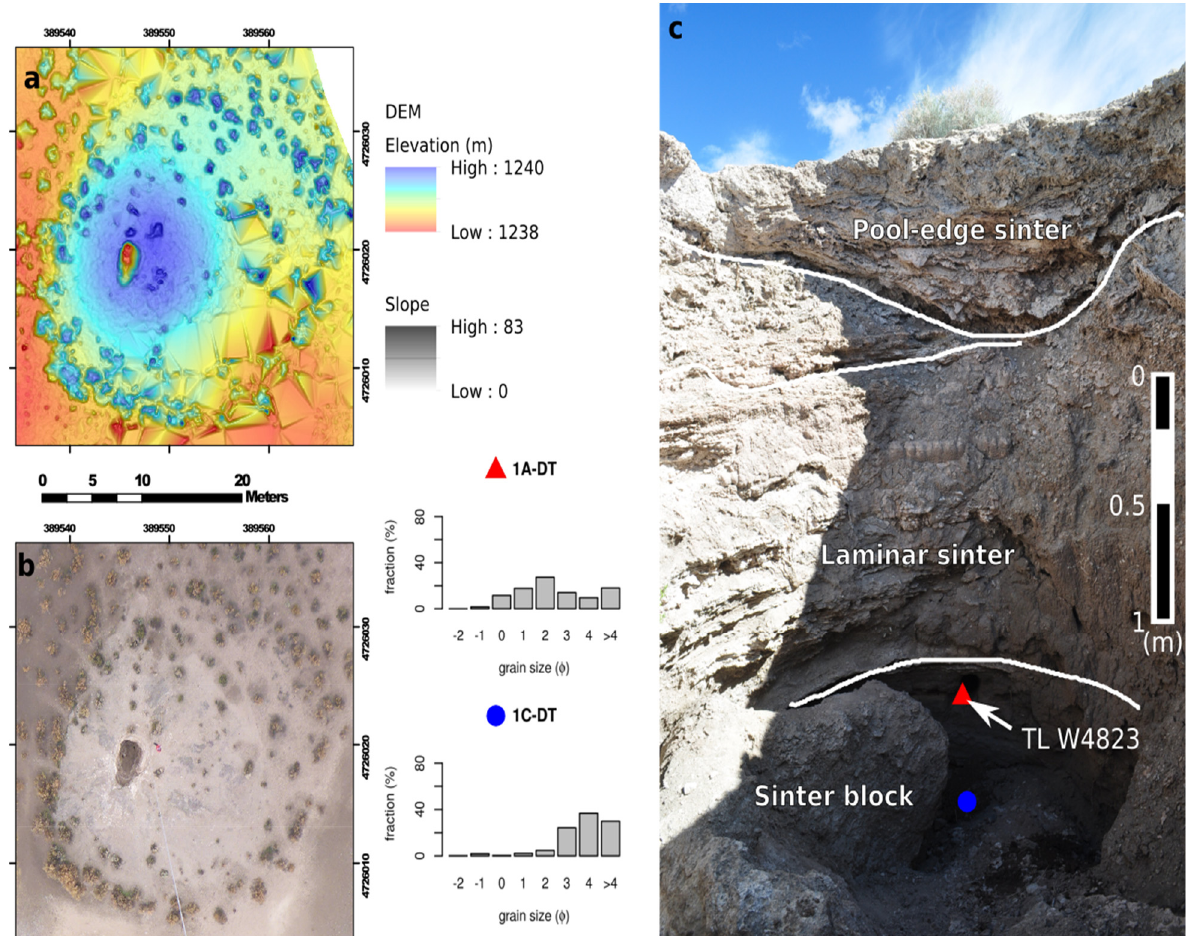
Figure 6. ( a ) Elevation model of the sinter apron of feature Q4 with a draped slope map to show detail. ( b ) Georeferenced aerial photo of feature Q4 at the same extent as ( a ). ( c ) Stratigraphy exposed in the central depression of feature Q4, looking north while standing on the floor of the central depression. Inward ‐ dipping pool ‐ edge sinter is exposed at the surface down to 90 cm. Laminar sinter interbedded with un ‐ cemented coarse ‐ grained sand is present from 90 cm to 2 m. Silicified root ‐ casts are present between layers of laminar sinter and in underlying coarse ‐ grained sand to 2.9 m. Location of the TL sample W4823 indicated by an arrow. Grain size charts of two sediment samples are shown in the center of the image, with the sample location indicated by the corresponding colored symbols.